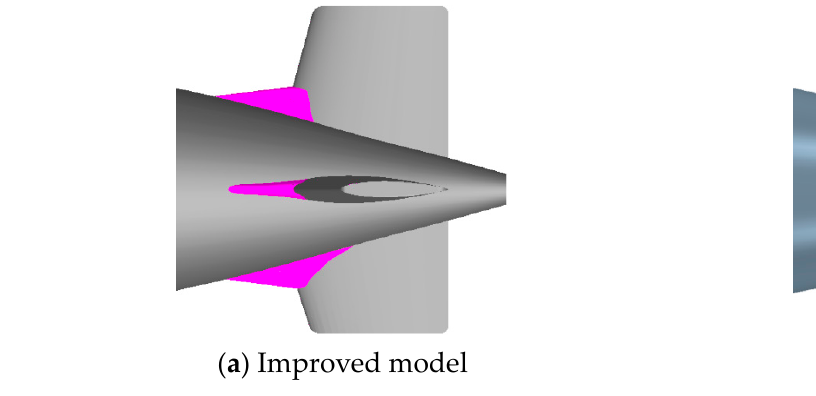
Figure 1. The tail rudder model. Figure 1.